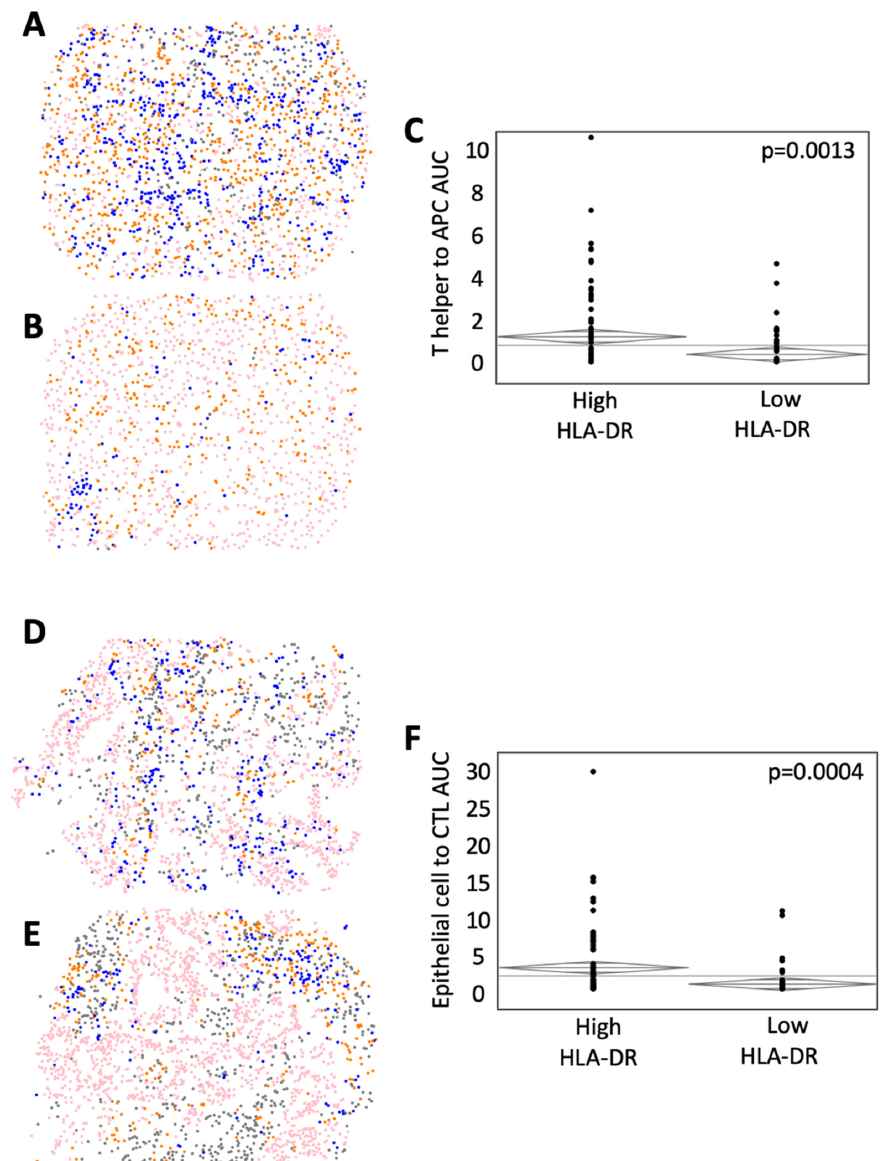
Figure 5. HLA-DR expression is associated with greater immune and epithelial cell population mixing in the TME. Representative phenotypic maps are shown of ( A ) high and ( B ) low T helper cell macrophage mixing (CD3 + T cells (blue), pancytokeratin-positive epithelial cells (pink), CD163 + antigen-presenting cells (orange), and other cells (gray). ( C ) ANOVA analysis of the area under the curve (AUC) of G-function curves, a mathematical representation of population-level cellular mixing between high and low HLA-DR expressing tumors. Representative phenotypic maps are shown of ( D ) high and ( E ) low CTL to epithelial cell mixing. ( F ) ANOVA analysis comparing G-function AUCs between high and low HLA-DR-expressing tumors.